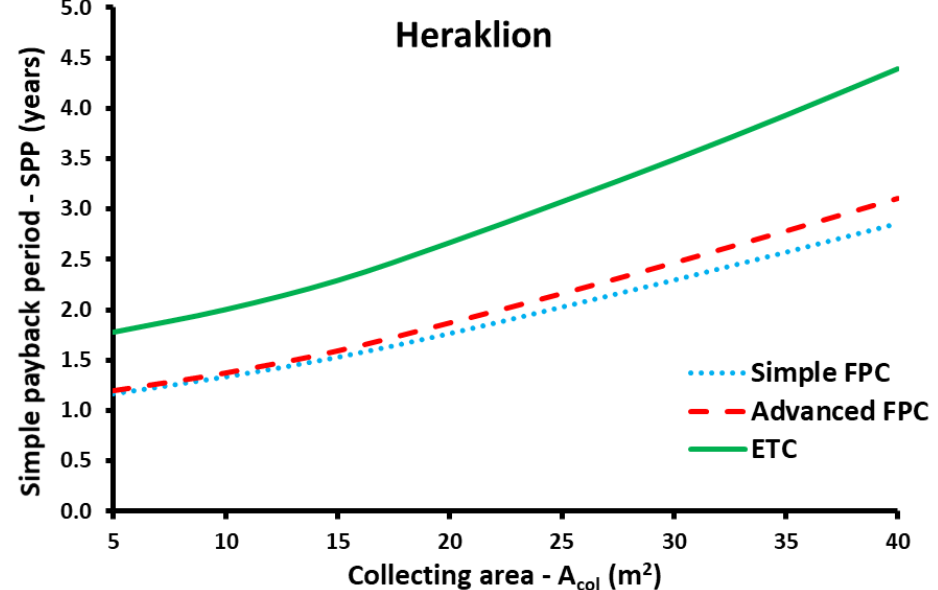
Figure 24. Simple payback period for different collecting areas and collector types for Heraklion.